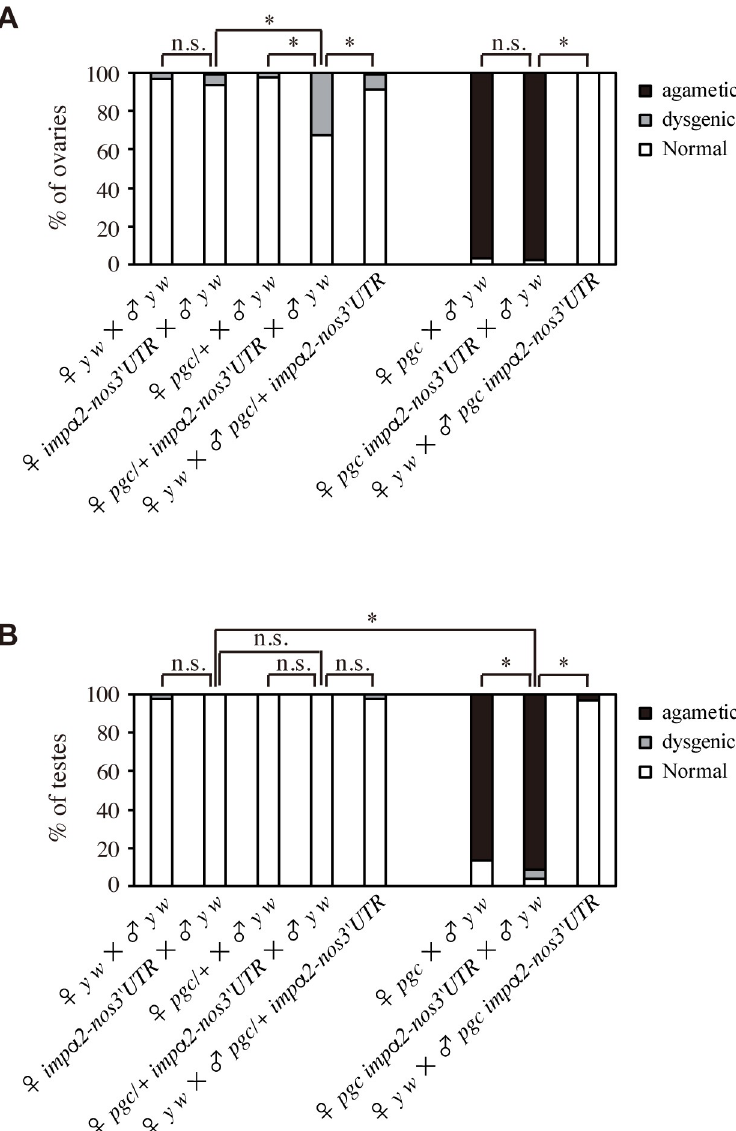
Fig 7. Mis-expression of Imp α 2 in pole cells affects gametogenesis. ( A and B ) Ovaries ( A ) and testes ( B ) of adults at 2–8 days after eclosion were examined. Flies were derived from y w , imp α 2-nos3´UTR , pgc/+ , pgc/+ imp α 2-nos3´UTR , pgc , and pgc imp α 2-nos3´UTR females mated with y w males, or from y w females mated with pgc/+ imp α 2-nos3´UTR or pgc imp α 2-nos3´UTR males. Percentages of ovaries ( A ) and testes ( B ) showing normal (white), dysgenic (gray), and agametic (black) phenotypes (see S5 Fig) are shown. For each genotype, 88–190 ovaries and 68–252 testes were examined. Significance was calculated using Fisher’s exact test ( � : P < 0.05, n.s.: P >